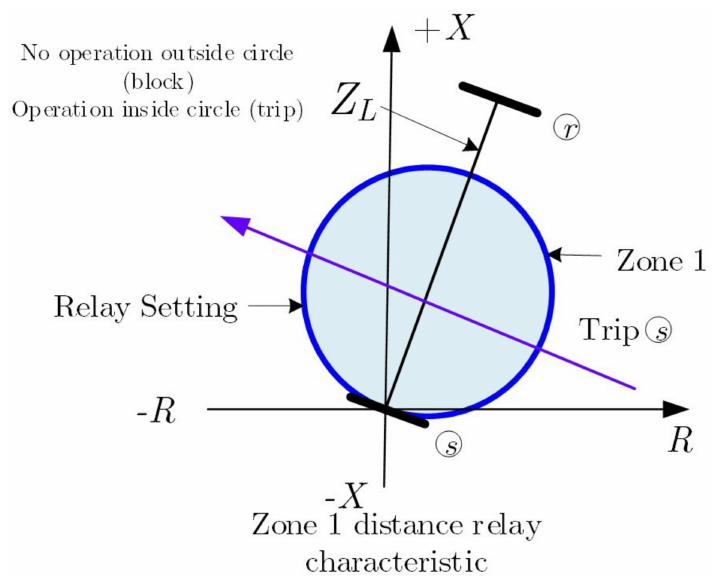
Figure 4. Zone 1 distance relay characteristic of R s in Figure 1.